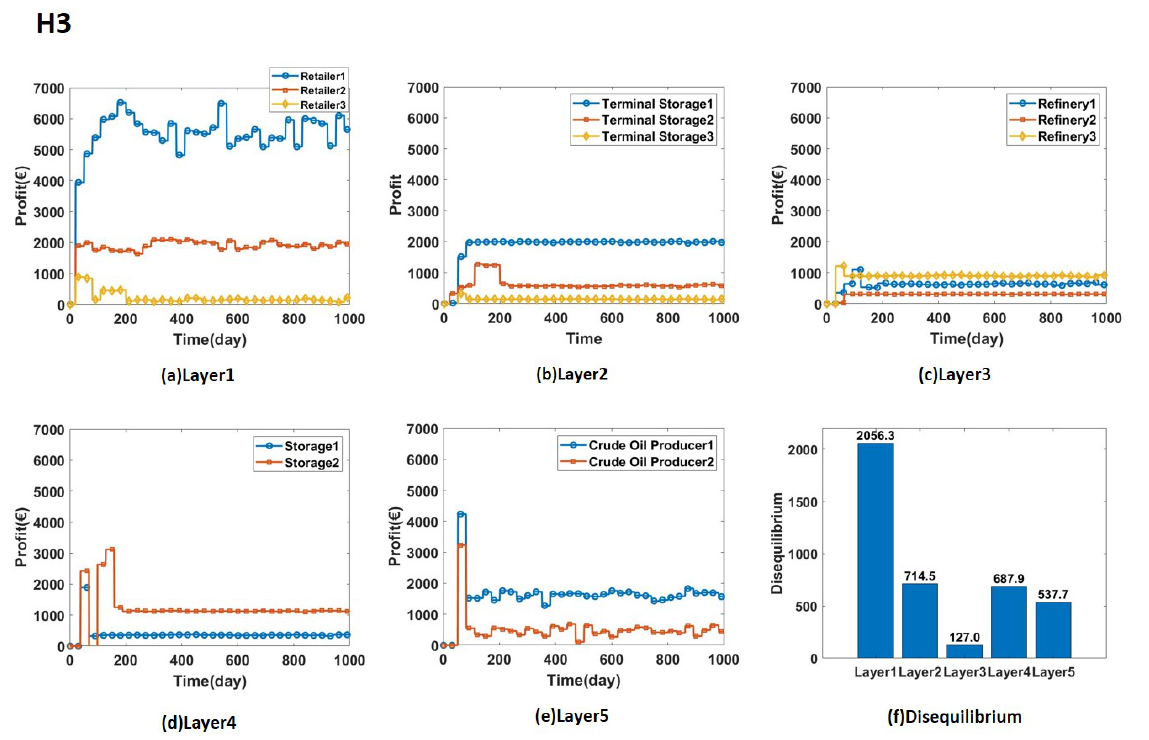
Figure A2. The profit and the disequilibrium of the profit for each layer considering variables of H 3